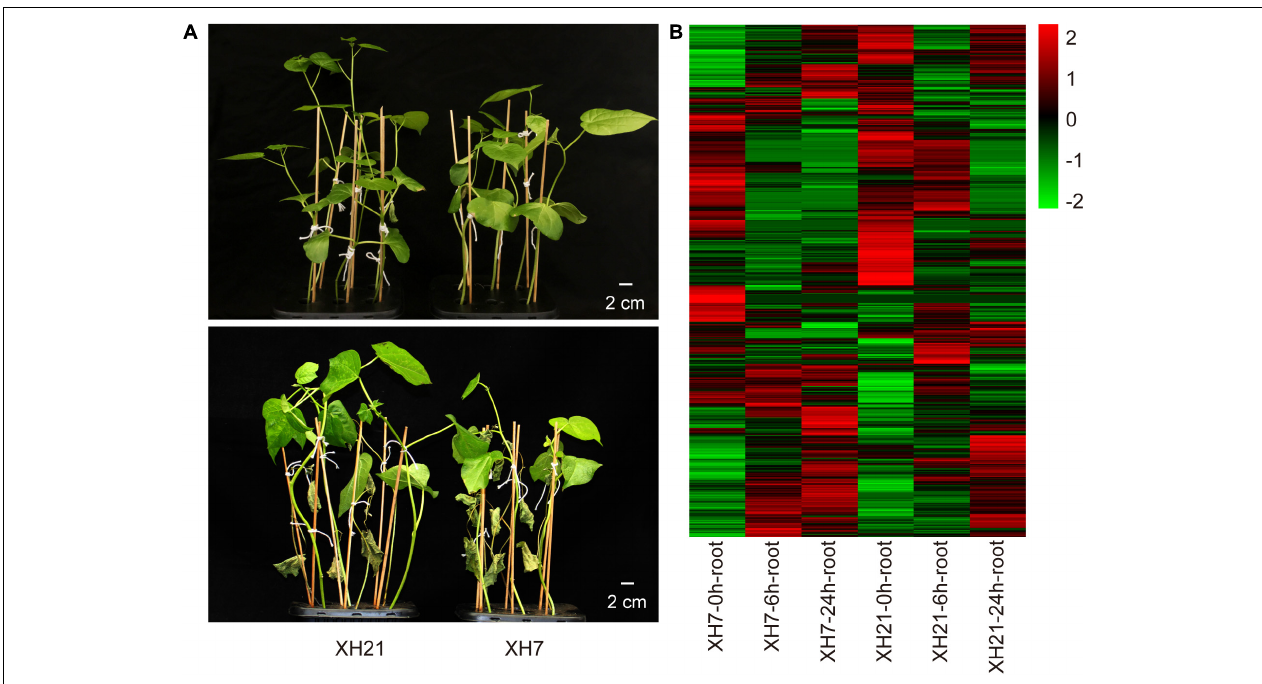
FIGURE 1 | Symptoms of Verticillium wilt disease and heatmap of differentially abundant proteins (DAPs). (A) Representative seedlings of XH21 and XH7 before (upper panel) and 21 days after (lower panel) incubation with Verticillium dahliae . Four-week-old seedlings were infected with V. dahliae and were photographed after 3 weeks. N = 18 for each group. (B) Heatmap of 885 DAPs. The Log 2 value of the expression levels of DAPs was used to produce the